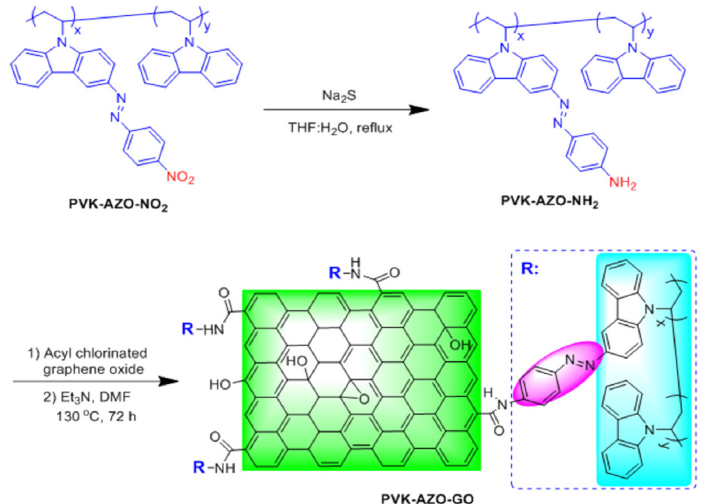
Figure 13. Synthesis of PVK-AZO-GO by an amide linkage. (Reprinted with permission from [107] Copyright @ 2018, Elsevier).